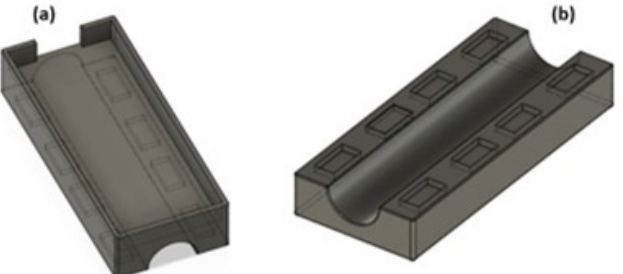
Figure 2. The CAD design of the first version of the mechanical support. ( a ) The housing for the electronic board. ( b ) The connection part for the positioning of the device along the EndoWrist